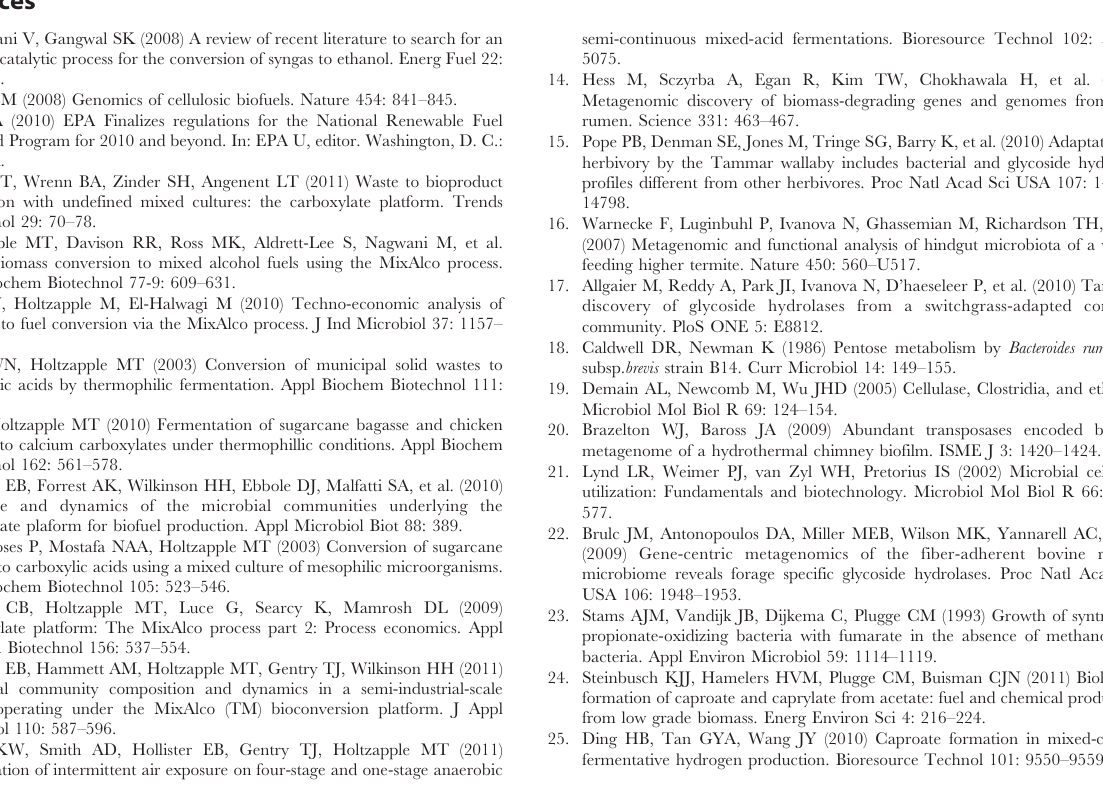
Table S3 Pfams significantly enriched or depleted between the thermophilic and mesophilic metagen- omes, as determined using a z -normalized log odds ratios (Z-LOR). Table S4 COGs significantly enriched or depleted between the thermophilic and mesophilic metagen- omes, as determined by z -normalized log odds ratios (Z-LOR). Table S5 Enzymes significantly enriched or depleted between the thermophilic and mesophilic metagen- omes, as determined by z -normalized log odds ratios (Z-LOR). Table S6 Genomes used to identify phylogenetic order- level core genes and conserved single copy genes